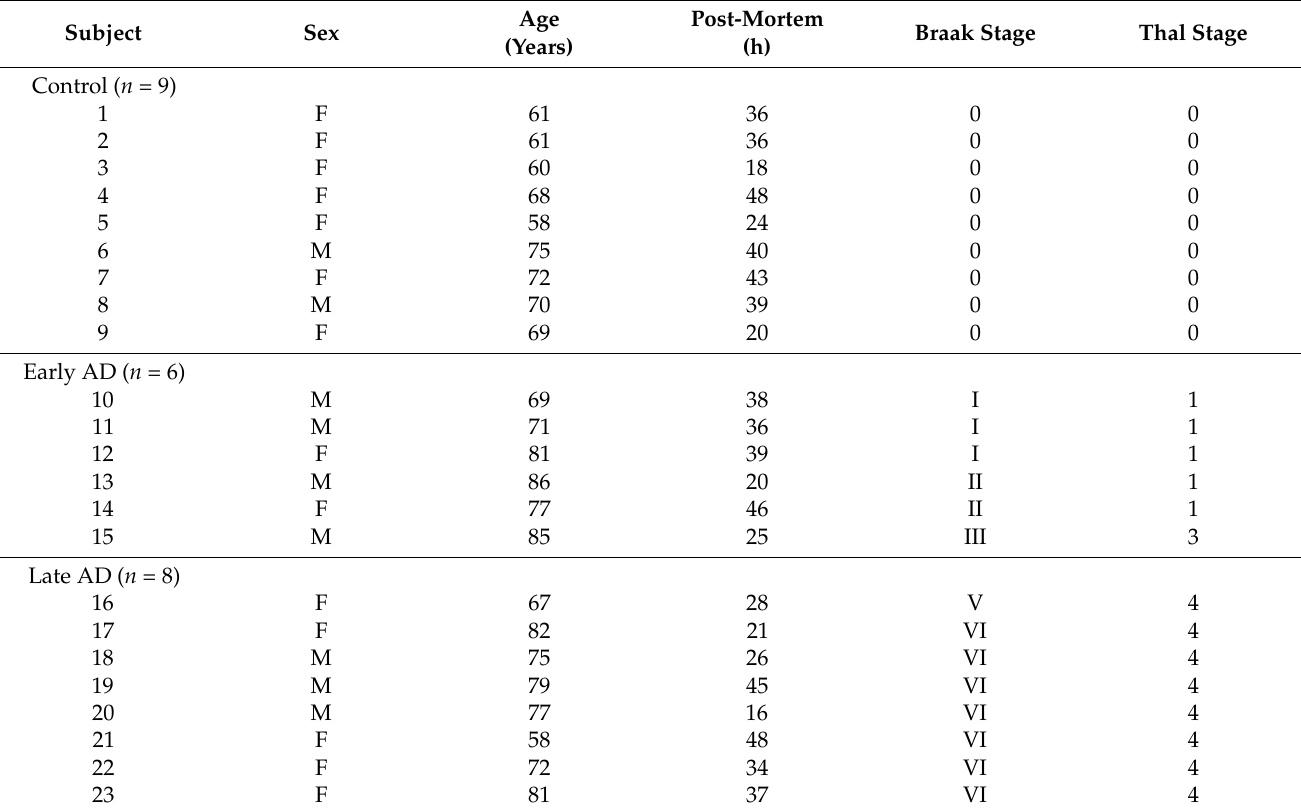
Table 1. Detailed information about the subjects included in the